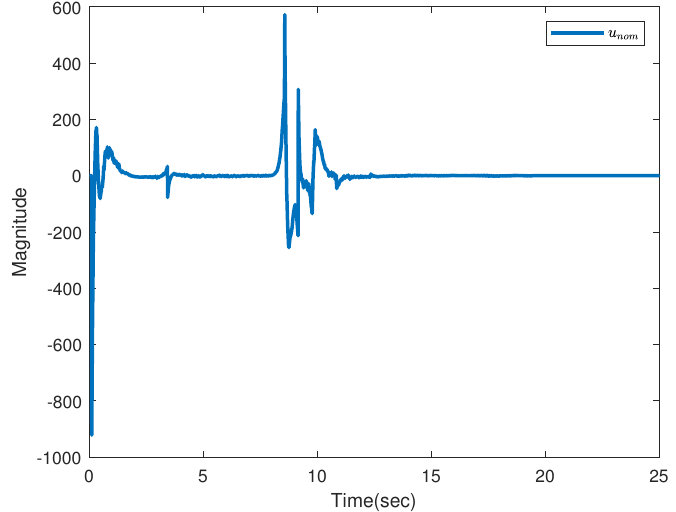
Figure 10. Time history of the nominal control input u d 2 based on the estimates produced by the observer (16) for the stochastic system